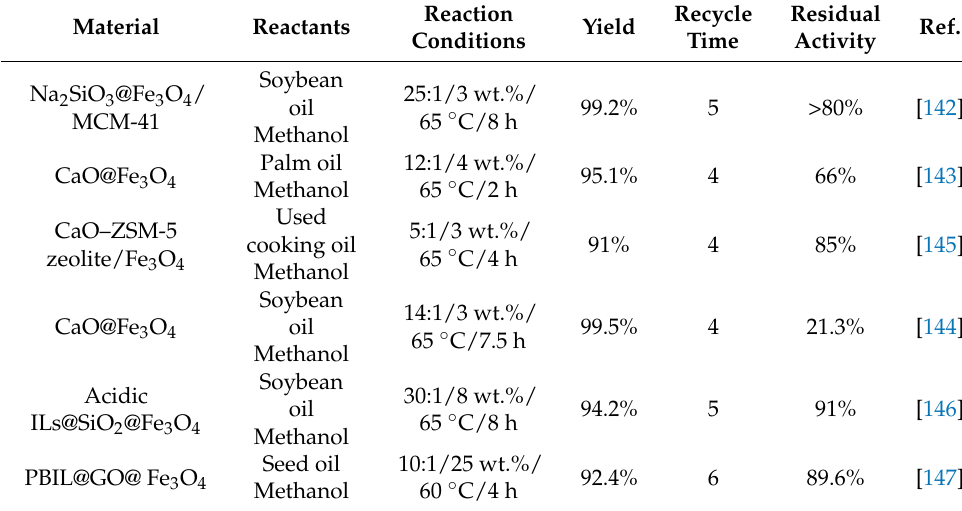
Figure 14. ( A ) Theoretical illustration of the recovery of the catalyst after the synthesis of biodiesel [145], Copyright 2022 Springer. ( B ) Image of the catalyst recovered by magnet after biodiesel generated [143], Copyright 2020 Elsevier. Table 3. Studies on the applications of Fe 3 O 4 as support in transesterification of triglycerides for biodiesel. The figures for the reaction conditions are shown in the following order: mole ratio of alcohol to oil, catalyst adopting (with respect to oil), reaction temperature, and reaction